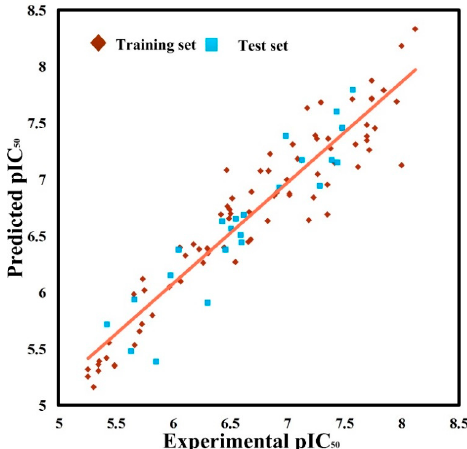
Figure 1. Scatterplot of predicted and experimental pIC (cid:2873)(cid:2868) values for the training (brown diamonds) and testing (blue squares) compounds from the optimal comparative molecular similarity indices analysis (CoMSIA) model. The solid line is the regression line for the predicted and experimental pIC (cid:2873)(cid:2868) values among the training and testing sets.